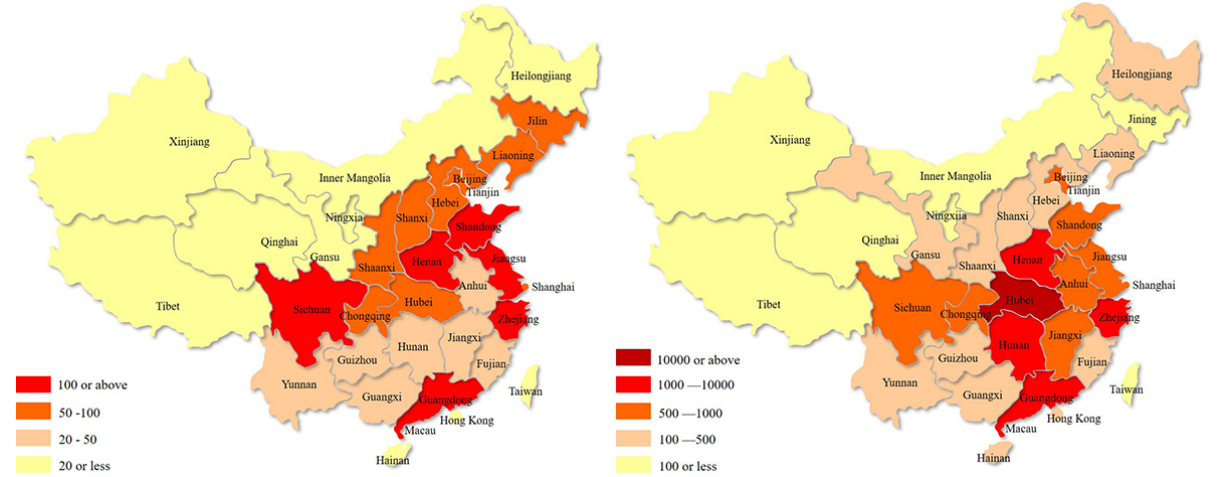
Figure 3. The geographic distributions of Weibo tweets (left) and total coronavirus disease cases (right) in the